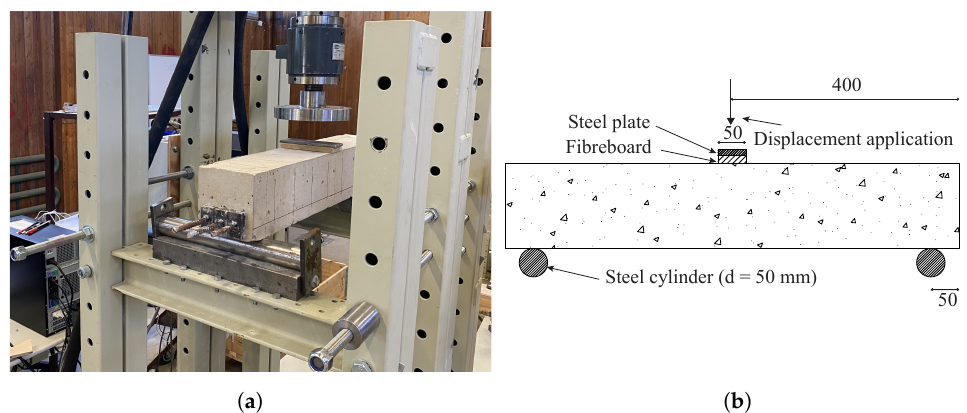
Figure 3. ( a ) Test setup used for the quasi-static tests; and ( b ) schematic of the setup.